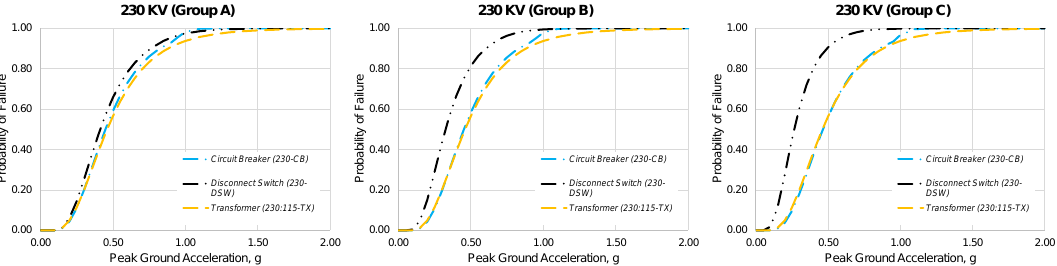
Figure 4. Fragility curves for circuit breakers (blue), disconnect switch (black) and transformers (yellow) for 57 kV, 115 kV and 230 kV voltage levels and for all 3 groups of assets A, B and